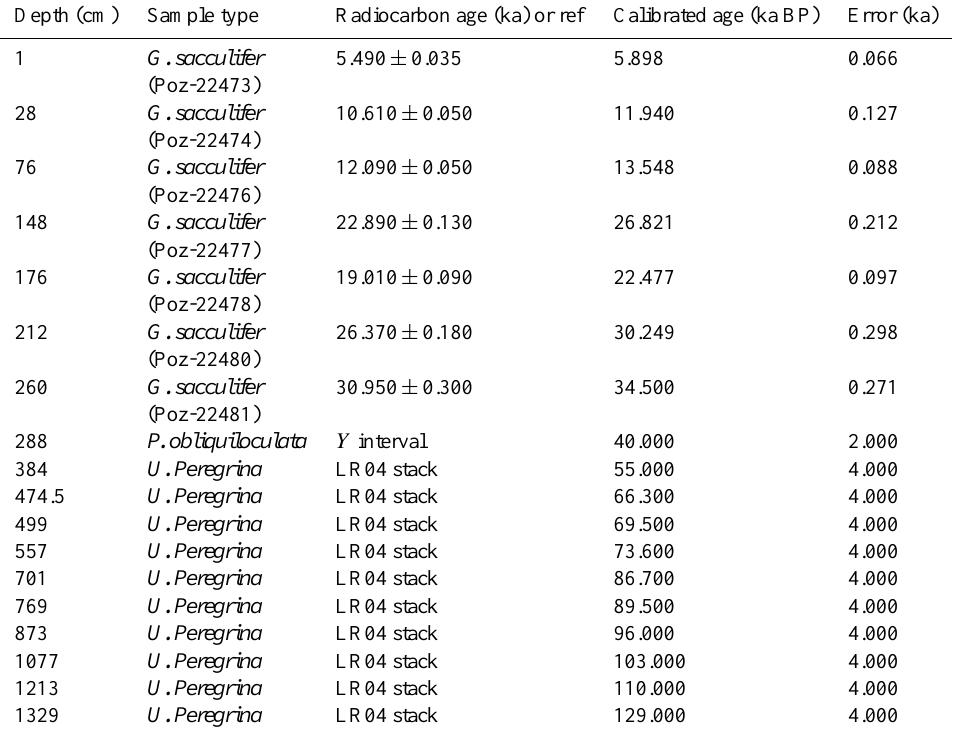
Table 1. Control points used for the age model in MD03-2616, assuming regular sediment accumulation rates between reference strata. Radiocarbon dating was carried out at the Poznan Radiocarbon Laboratory (Poz-code, Poznan, Poland) and dates were calibrated using Calib 7.0 software and the Marine13 curve (Reimer et al., 2013; reservoir age of 284 years and delta R of − 15 ± 37; 1 sigma range; reservoir age and delta R were obtained from the website http://calib.qub.ac.uk/marine/). Note that a reversal reported at 148cm was not used in the age model, the Pulleniatina obliquiloculata disappearance is located at 288cm (López-Otálvaro et al. 2009) and the LR04 benthic δ 18 O calcite stack (Lisiecki and Raymo, 2005) is used as a reference for the older